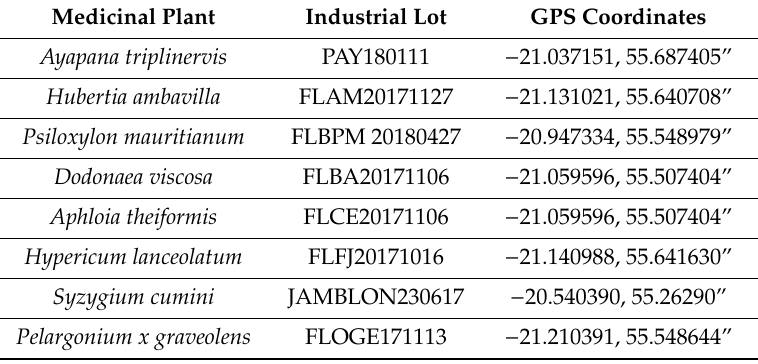
Table1. Industriallotsandrawmaterialcroplandlocalizationaccordingtotheglobalpositioningsystem. Medicinal